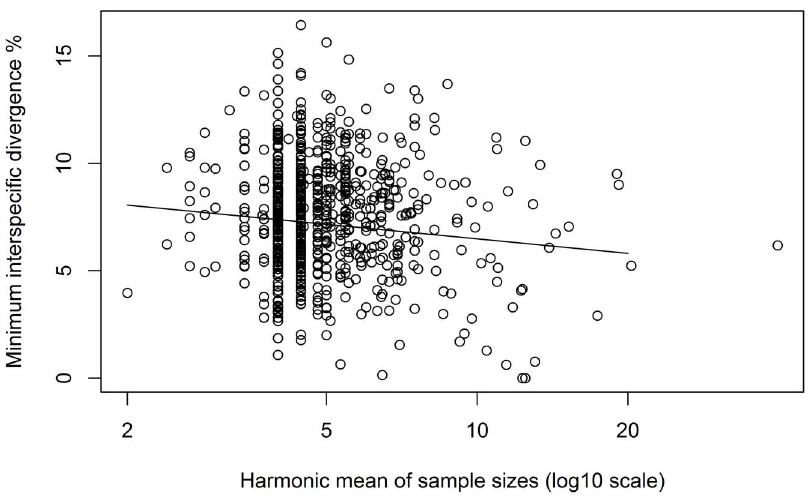
Fig. 4. Decrease in the minimum distance (K2P) to nearest neighbour (NN) species with increasing sample size. To account for the impact of small sample sizes, the harmonic mean of the sample size for the focus species and its NN was